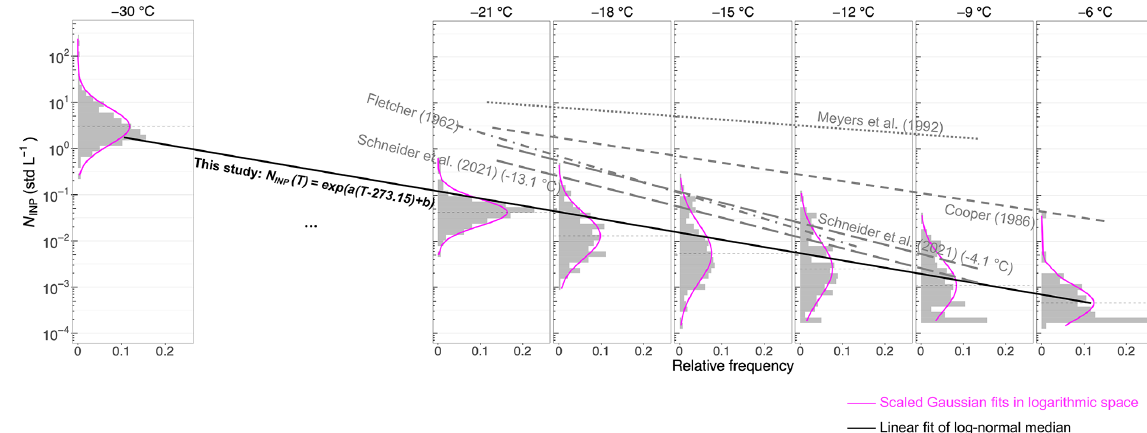
Figure 6. Relative frequency distribution of observed INP concentrations (gray histograms) for selected nucleation temperatures. Log-normal fit curves are presented for each histogram in magenta. The fit of all INP data in this study is presented as a solid black line (fitting parameters given in Table 1). Predictions from existing parameterizations are indicated by the gray lines. For Schneider et al. (2021), the temperature value in parentheses represents the mean ambient temperature during the observations in autumn 2019 and spring 2020, respectively, which were used to obtain the INP